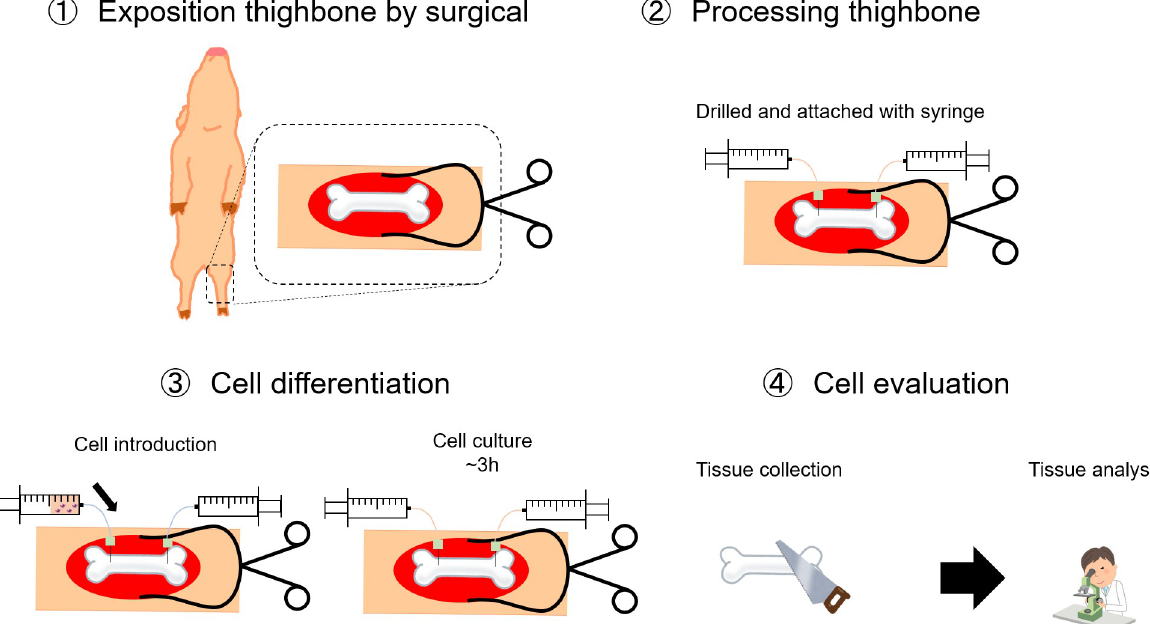
Fig 1. The in vivo production system procedure. (1) Porcine thighbone was surgically exposed by using retractors. (2) The thighbone was drilled and attached with syringe. (3) Megakaryocytes were introduced into the thighbone by perfusion and then cultured for 3hours. (4) After harvesting thighbone; bone marrow was frozen and later analyzed by tissue immunohistochemical